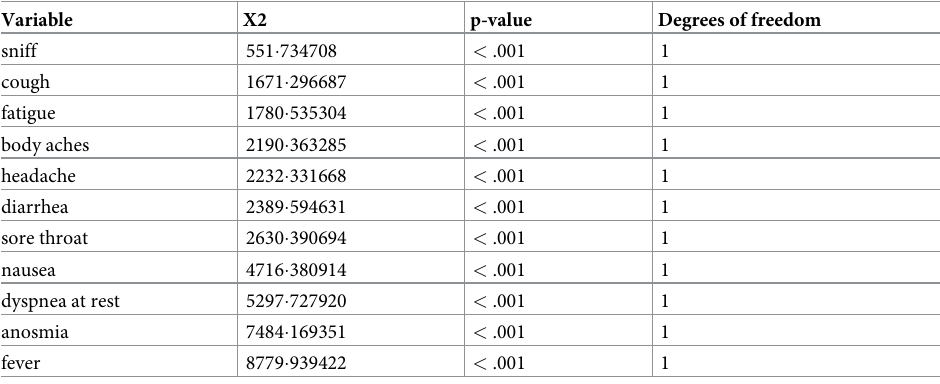
Table 2. Results of the chi-square test of independence. Variable X2 p-value Degrees of freedom sniff 551 � 734708 < .001 fatigue 1780 � 535304